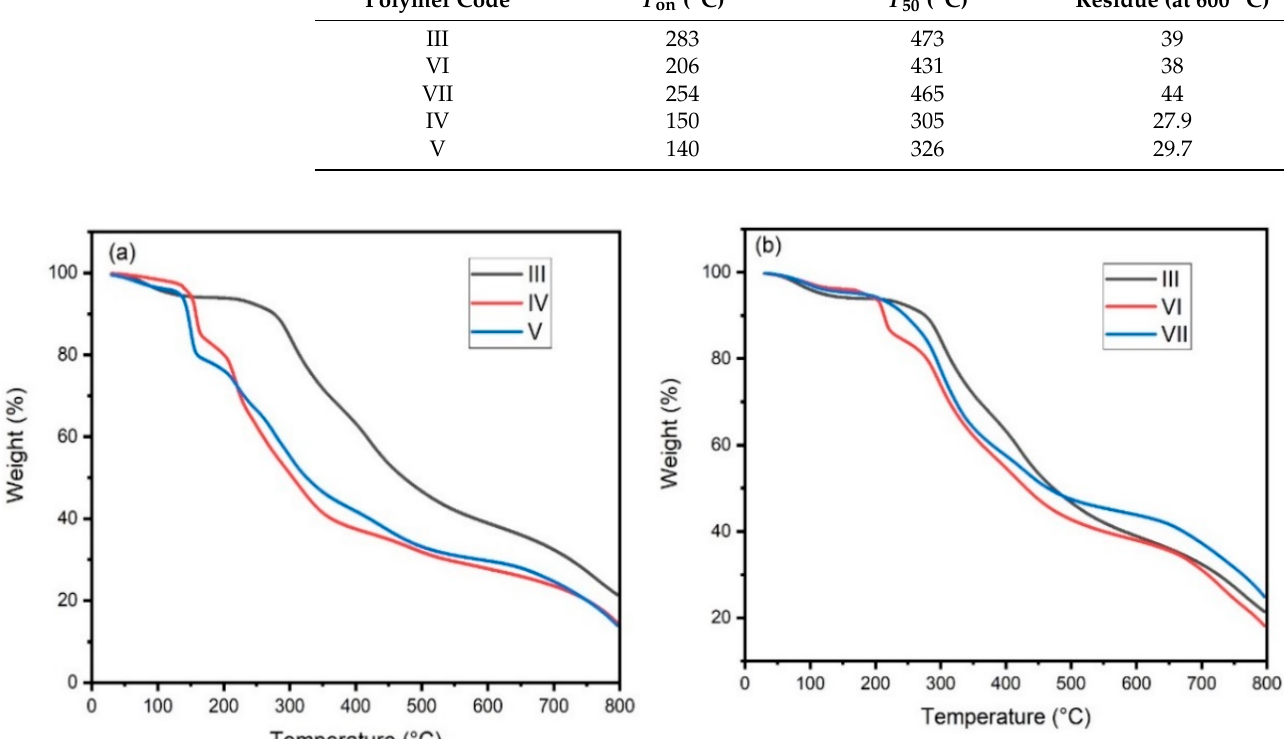
Figure 2. TGA thermogram of polymers ( a ) III–V and ( b ) III, VI and